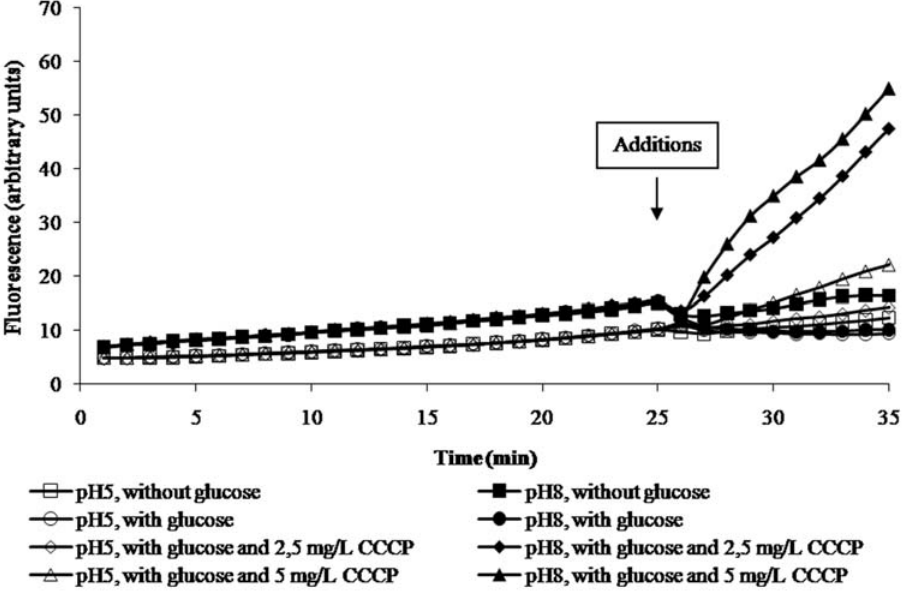
Figure 3. Effect of CCCP concentrations on efflux of EB by E.coli AG100 TET at pH 5 and 8. The same protocol of accumulation was followed as for Figure 2. After 25 minutes, saline with glucose and CCCP was added to the tubes. The control without CCCP and without glucose is also presented.